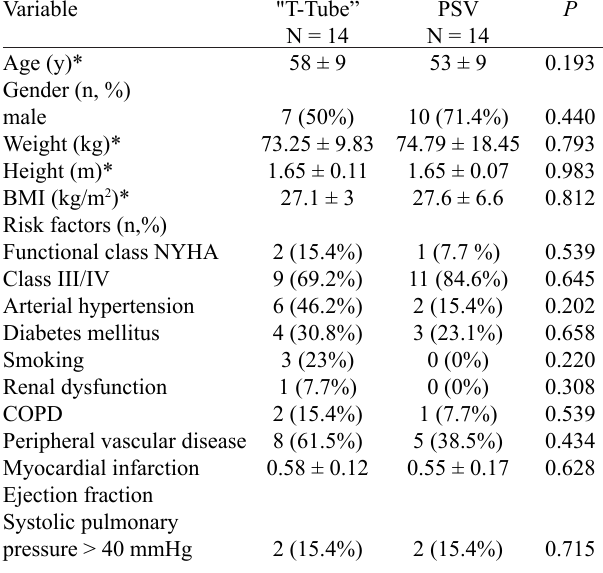
Table 1. Clinical